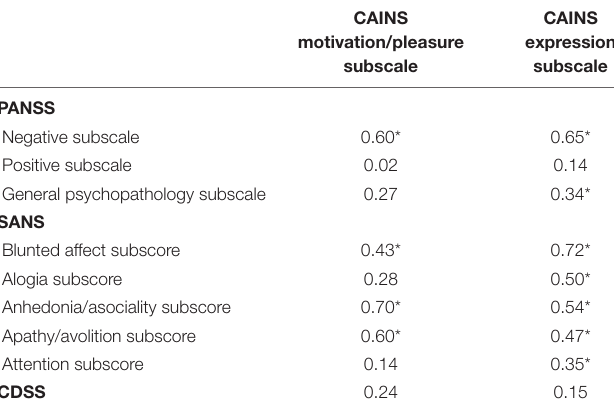
TABLE 4 | Convergent and discriminant validity of the